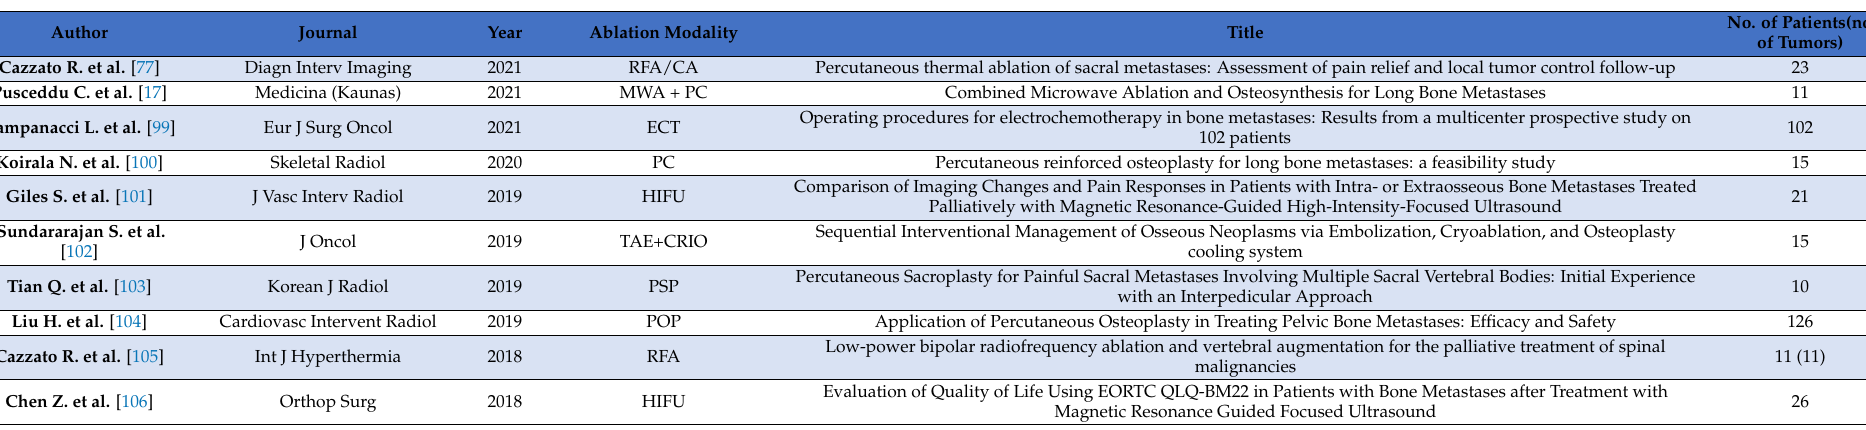
Table 4. Results of palliative ablation and combined of the treatment of bone fracture and impending